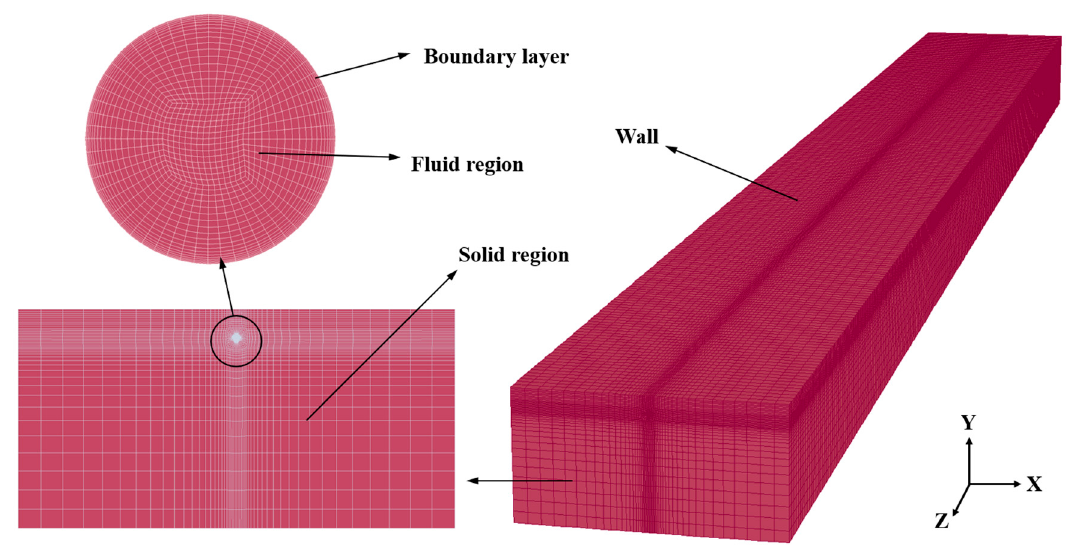
Figure 2. The mesh of the simulation model.